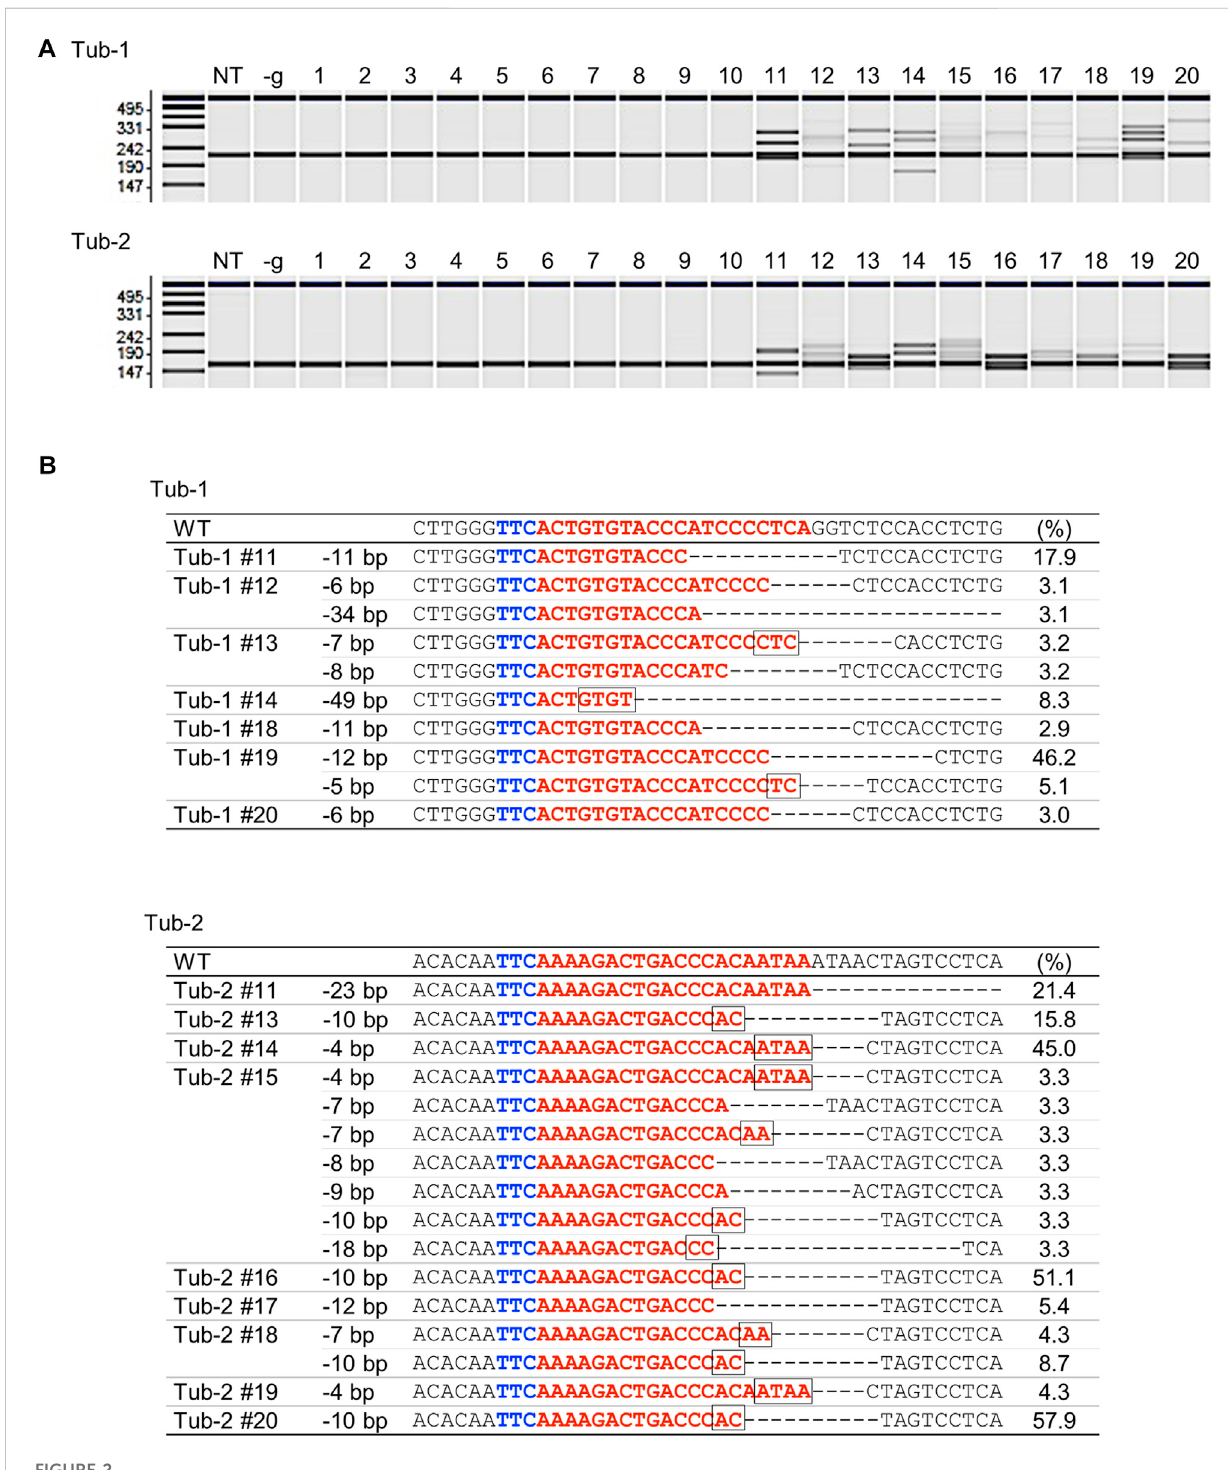
FIGURE 2 Analysis of SpCas12f-induced mutations in rice calli (A) Heteroduplex mobility assay (HMA) to detect mutations on Tub-1 (upper panel) and Tub-2 (lower panel) in transformed calli. We picked up 10 HMA-negative samples and 10 HMA-positive samples from Supplementary Figure S1. The numbers 1 – 10 and 11 – 20 indicate representative HMA-negative and -positive samples, respectively. NT; non-transformed, -g; calli transformed with pPZP- SpCas12fvectorwithoutsgRNA. (B) ExamplesofSangersequencingresultsinHMApositivesamplesonTub-1(upperpanel)andTub-2(lowerpanel) in transformed calli. Blue and red letters on the sequence indicate the PAM sequence and the target sequence, respectively. The square box on the